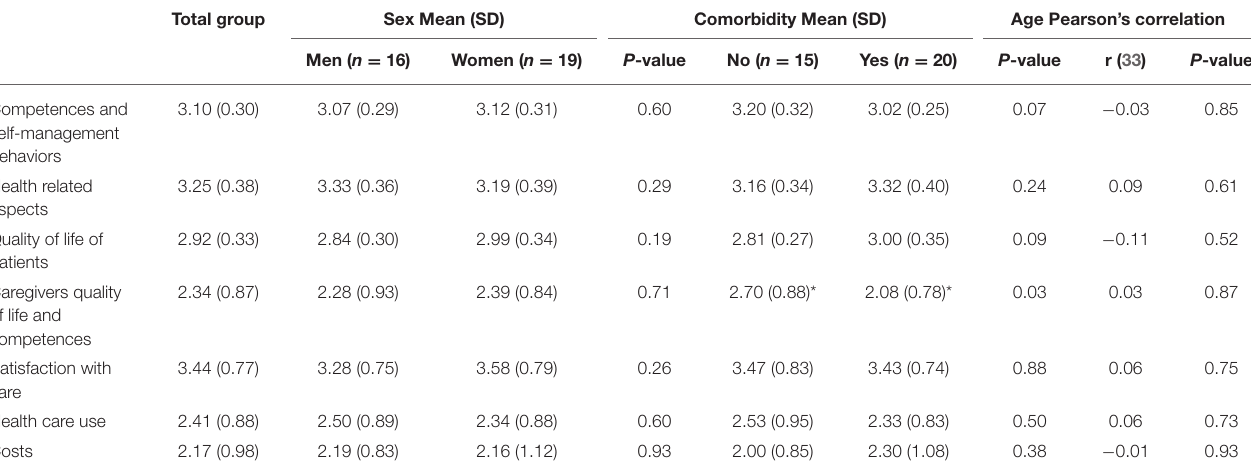
TABLE 4 | Mean scores of outcome preferences by background